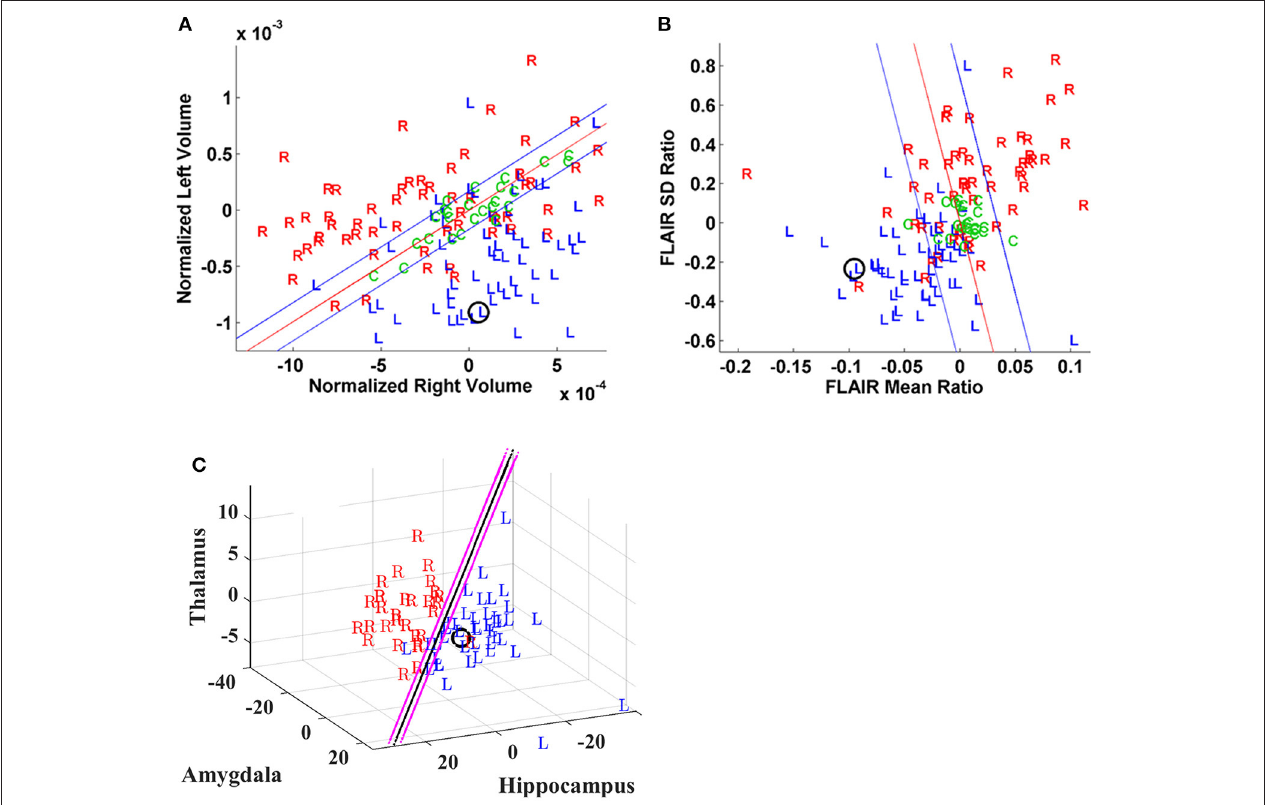
FIGURE 1 | Case P15. Quantitative neuroimaging analysis in a patient who underwent Phase I study followed by a left temporal resection and achieved an Engel class I outcome. The epileptogenic site was predicted accurately by models for this case. The prospective case is shown (O). (A) Scatter plot of normalized hippocampal volumes showing distribution of control subjects (C) and study cases by their laterality for epileptogenicity (i.e., left vs. right). The volumes of control subjects are clustered and define the boundary domain (blue lines) within which the separation of a right- or left-sided mesial temporal lobe epilepsy (mTLE), to either side of the decision line (red line), may not be possible. (B) Scatter plot of mean and standard deviation ratios (right/left) of fluid-attenuated inversion recovery (FLAIR) MR signal intensity with control subjects (C) clustered in the boundary domain and study cases distinguished by their laterality for epileptogenicity (i.e., left vs. right). (C) The logistic decision plane of the multistructural analysis (MSA) model uses the normalized bilateral volume change [i.e., 100(vL – vR)/(Vl + vR)] of thalamic, amygdalar and hippocampal volumes to lateralize the prospective (O) case. Note that the decision plane is parallel to the angle of view; hence, it is seen as a line in two